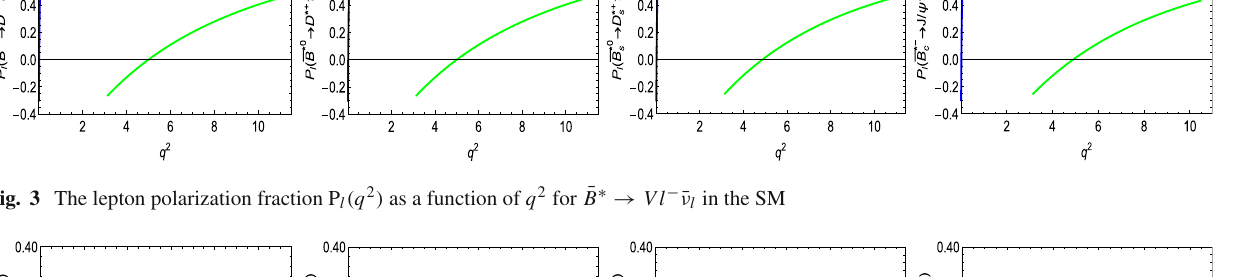
( q 2 ) as a function of q 2 for ¯ B ∗ → Vl − ¯ ν L